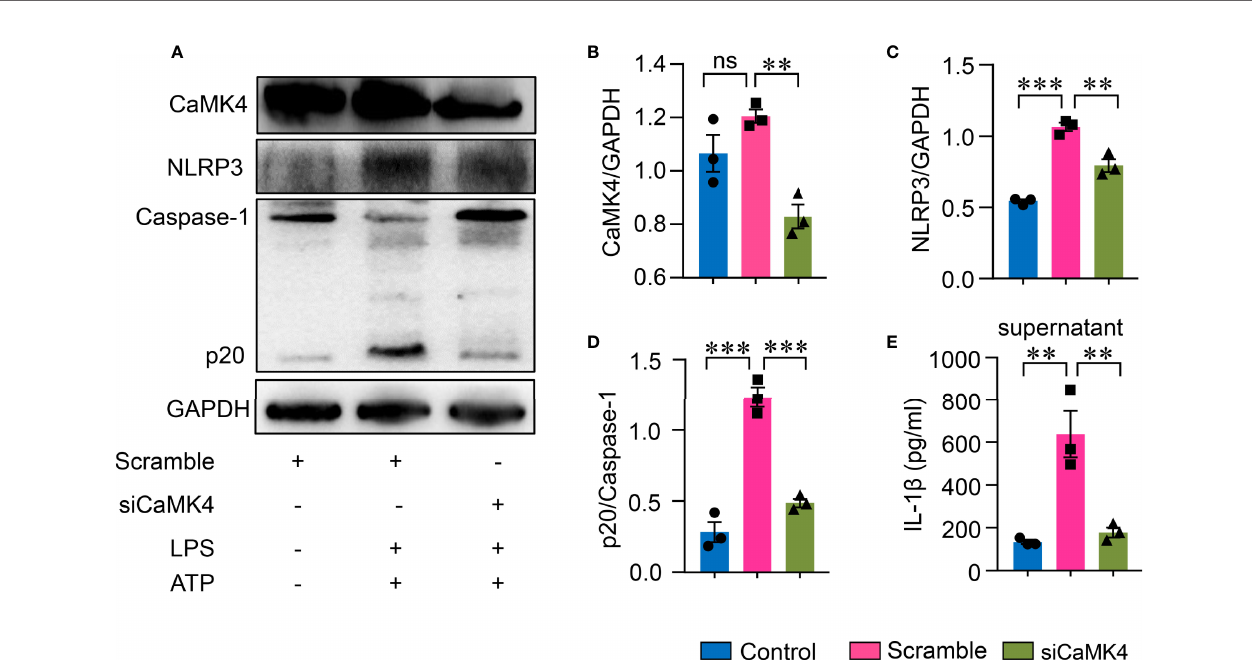
FIGURE 5 | Knockdown of CaMK4 inhibited NLRP3 in fl ammasome activation in type II lung alveolar epithelial cells. CaMK4 expression in A549 cells were knocked down using CaMK4 speci fi c siRNA and stimulated with LPS+ATP or PBS. (A – D) CaMK4, NLRP3, Caspase-1p20 and GAPDH expression was measured by Western blot. Representative bands were shown and relative expression summarized from 3 independent experiments. (E) IL-1 b in supernatants from A549 cells was determined by ELISA. All data are mean± SEM. ns, not signi fi cant. **p < 0.01, ***p <